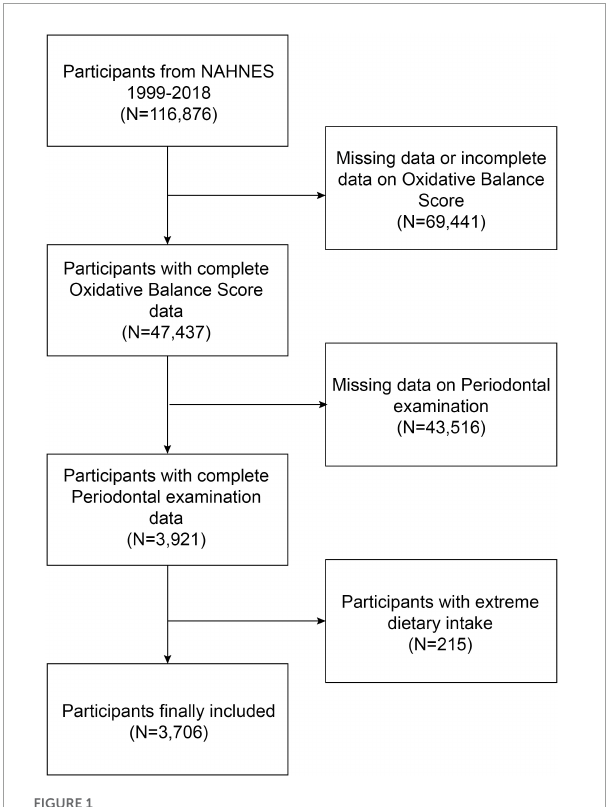
FIGURE1 Flow chart of participants selection. NHANES, National Health and Nutrition Examination